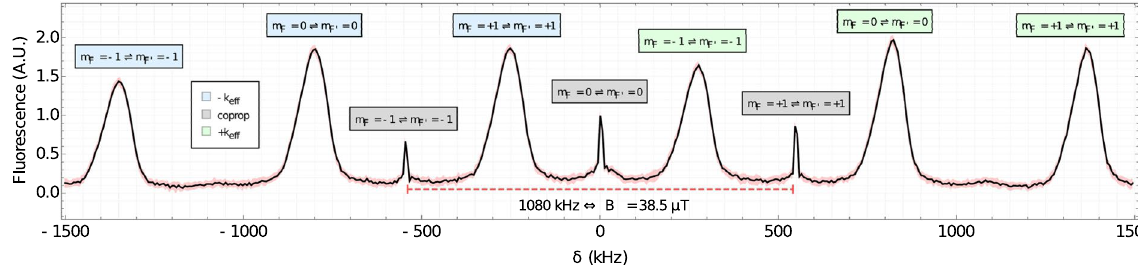
Figure 9. Counter-propagating Raman spectroscopy - after cooling and launching atoms in the F = 2 manifold, with an applied magnetic field. We scan the 3 MHz around the hyperfine splitting (6.834 GHz) symmetrically. We use a π -pulse with characteristic time 94 μ s. We observe multiple features: the magnetic sublevels have their degeneracy lifted by 38.5 μ T field, applied along the direction of the interrogation laser, the co-propagating transitions (labeled in gray) are visible due to slight polarization error on our injection mirror, and the Doppler- sensitive transitions ( ± k eff (green and red, respectively). These data consist of 5000 points, with each point an average of 10 shots. The red shaded region is the minimum and maximum range of value.